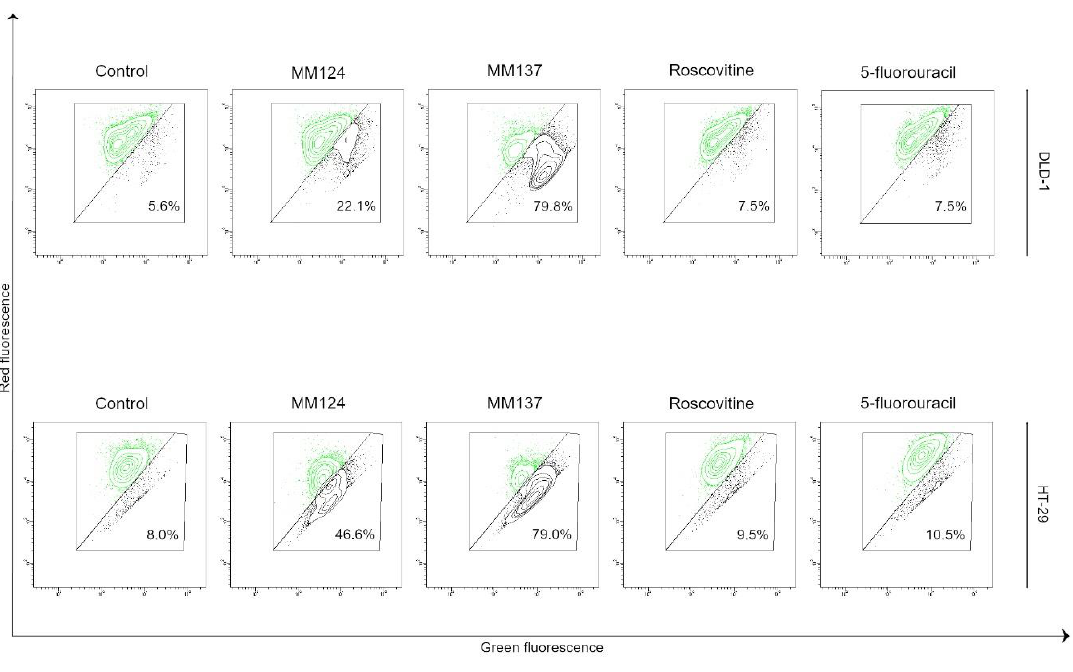
Figure 5. Fluorescence measurement of mitochondrial membrane potential in HT-29 and DLD-1 human colorectal adenocarcinoma cell lines incubated for 24 h with novel 7-methyl-5-phenyl-pyrazolo[4,3- e ]tetrazolo[4,5- b ][1,2,4]triazine sulfonamide derivatives (MM124, MM137), 5-fluorouracil, and roscovitine at 0.5 µM concentration. X- and y- axes are green and red fluorescence, respectively. Mean percentage values from three independent experiments done in duplicate are presented.